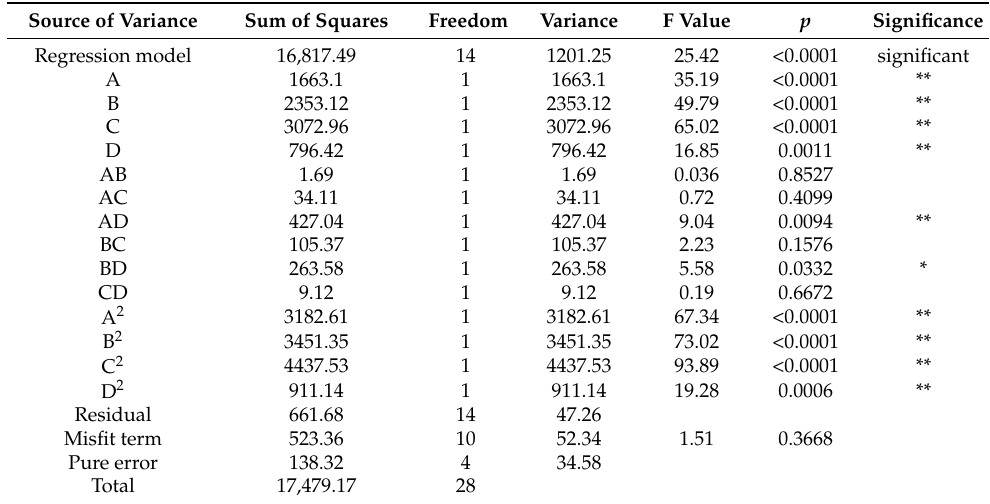
Table 4. Variance analysis of response surface-fitting regression equation for phosphate